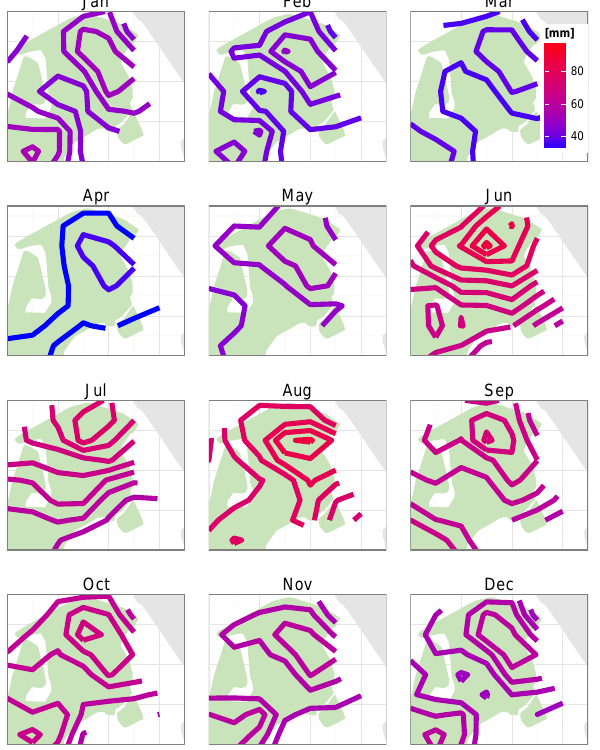
Figure 3. Spatial variation of the mean monthly precipitation cal- culated from the CGD data set for the model area. Isohyets are sep- arated by 3mm.